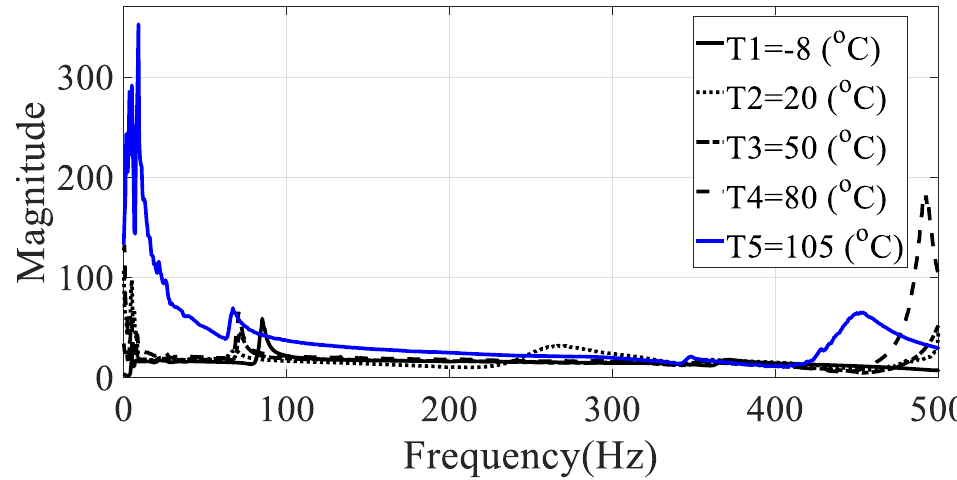
Figure 7. Representative frequency response function of specimen III ( 𝜙 = 45 degrees ) .